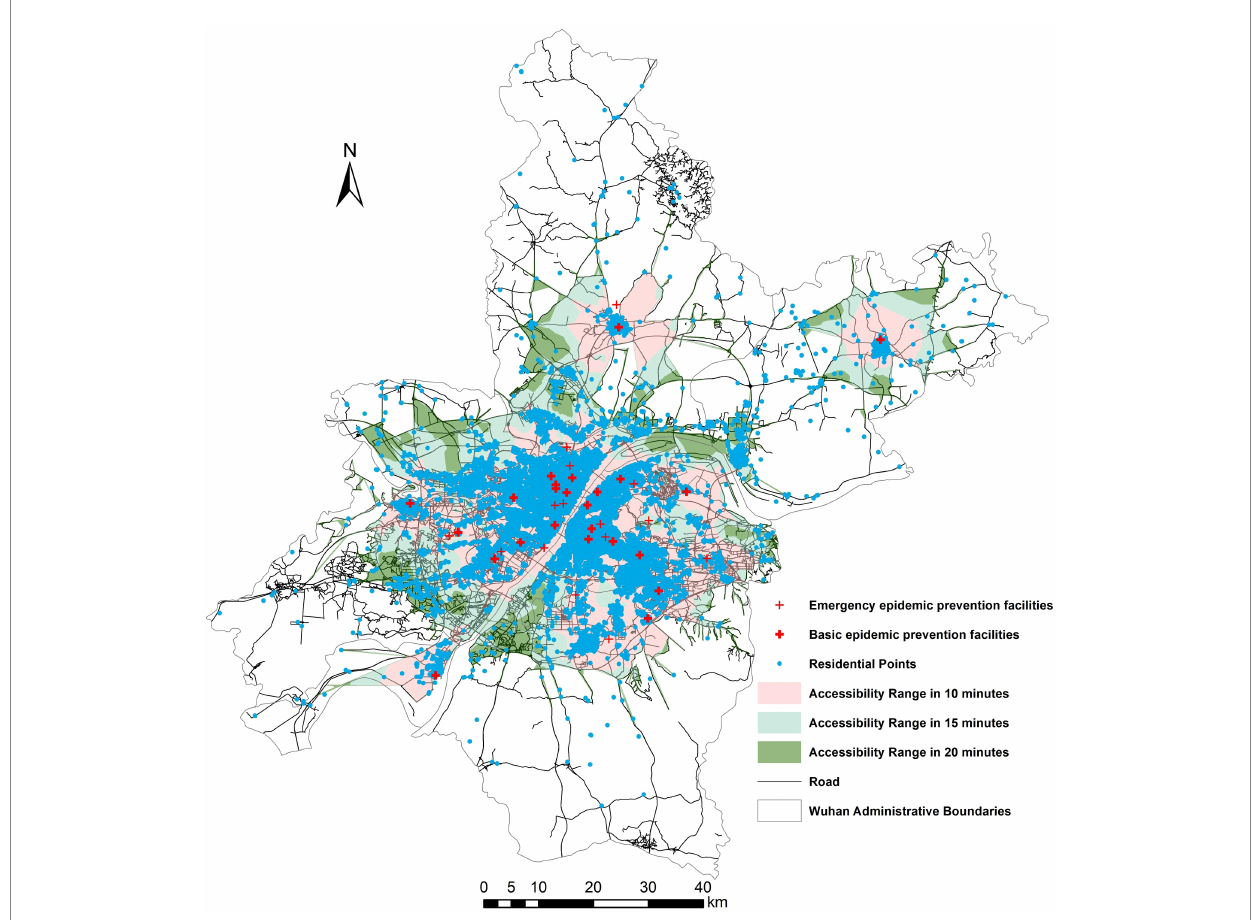
FIGURE 6 Analysis of the accessibility of epidemic prevention facilities and the overlay of residential sites in